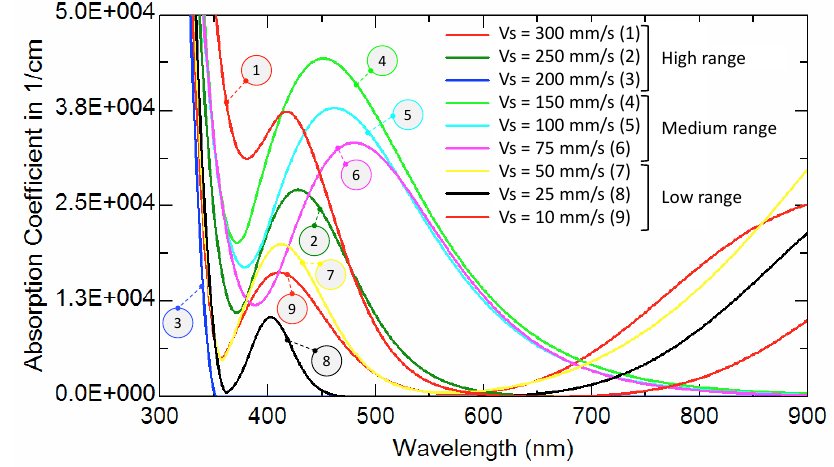
Figure 9. Absorption coefficient values of the laser textures.